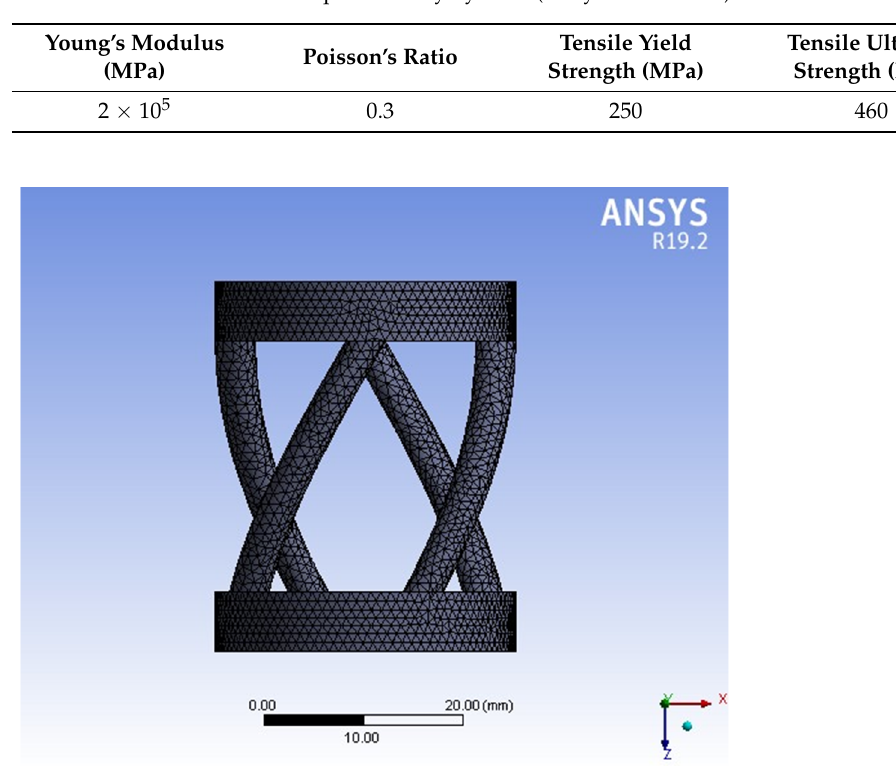
Figure 4. The meshing of the model.